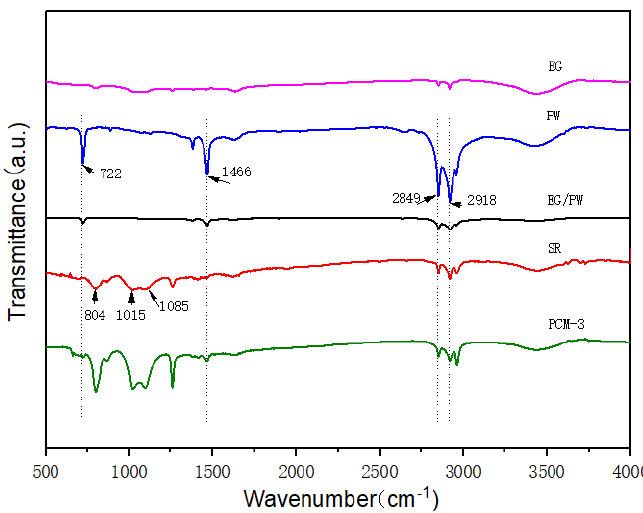
Figure 3. FTIR cures of EG, PW, EG/PW, SR and PCM-3.